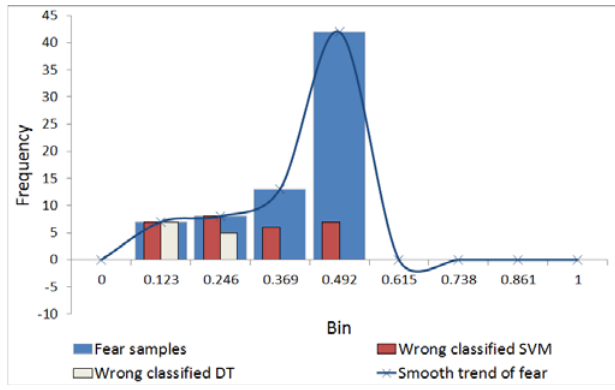
Figure 10. Histogram of Fear